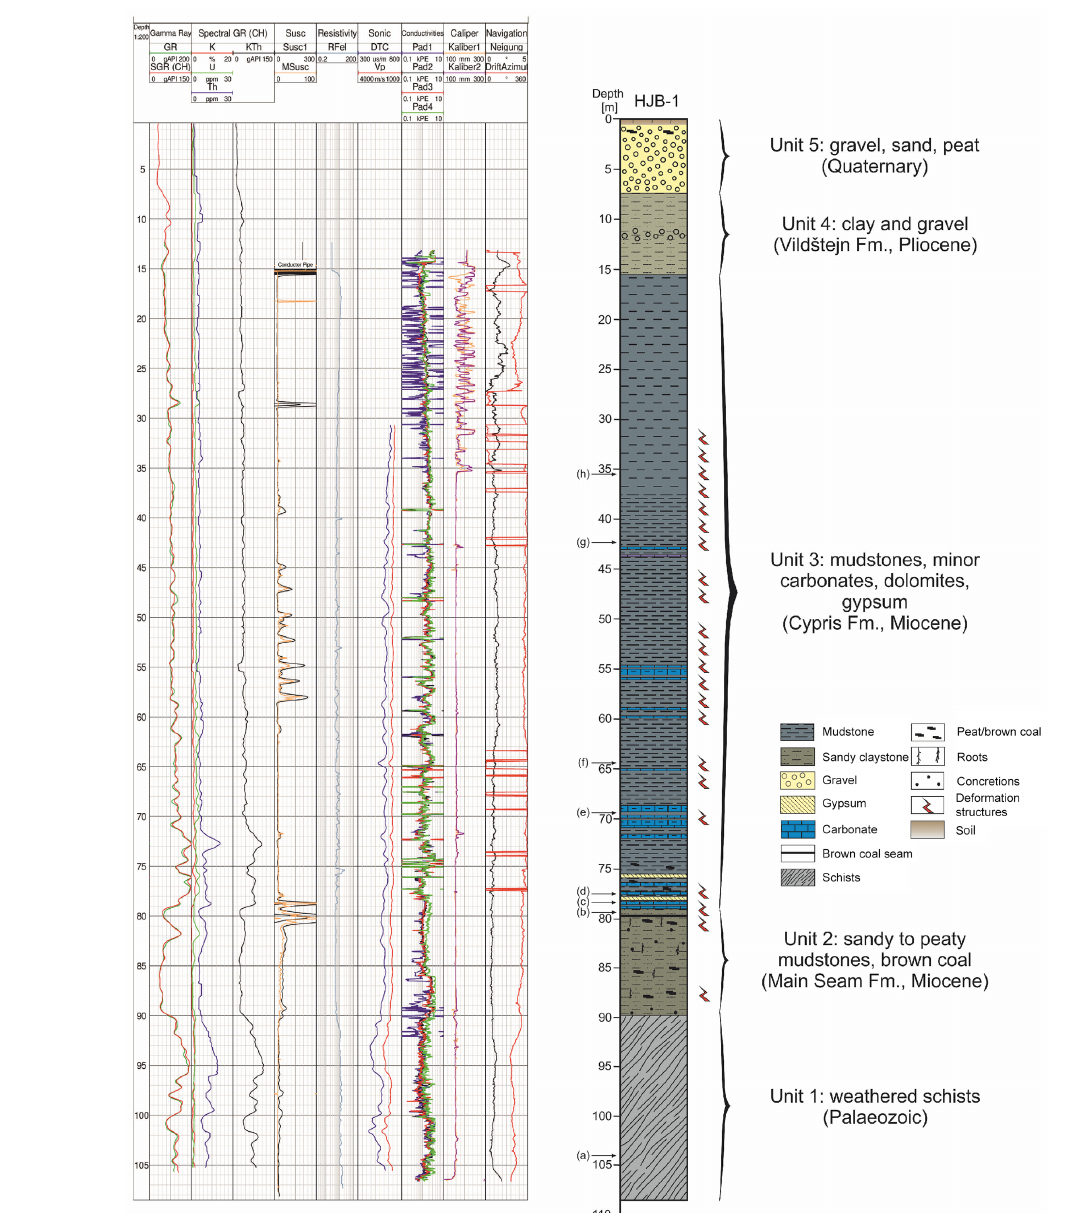
Figure 8. Logging data of well HJB-1 and summary stratigraphy based on initial core description results. Positions of cores in Fig. 9 are indicated by corresponding labels (a–h) and